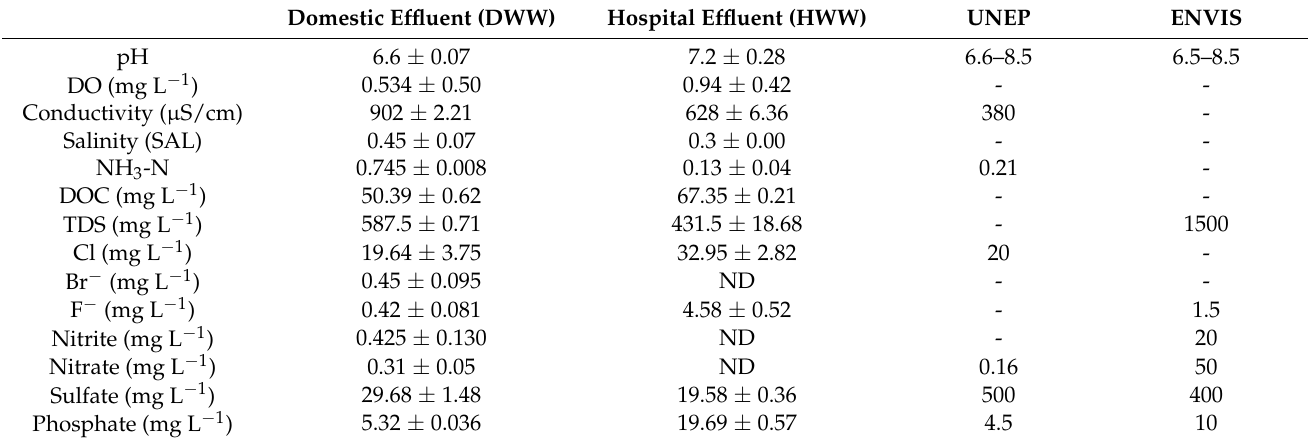
Table 1. Physico-chemical characteristics of the wastewaters studied (mean ± SD). Domestic Effluent